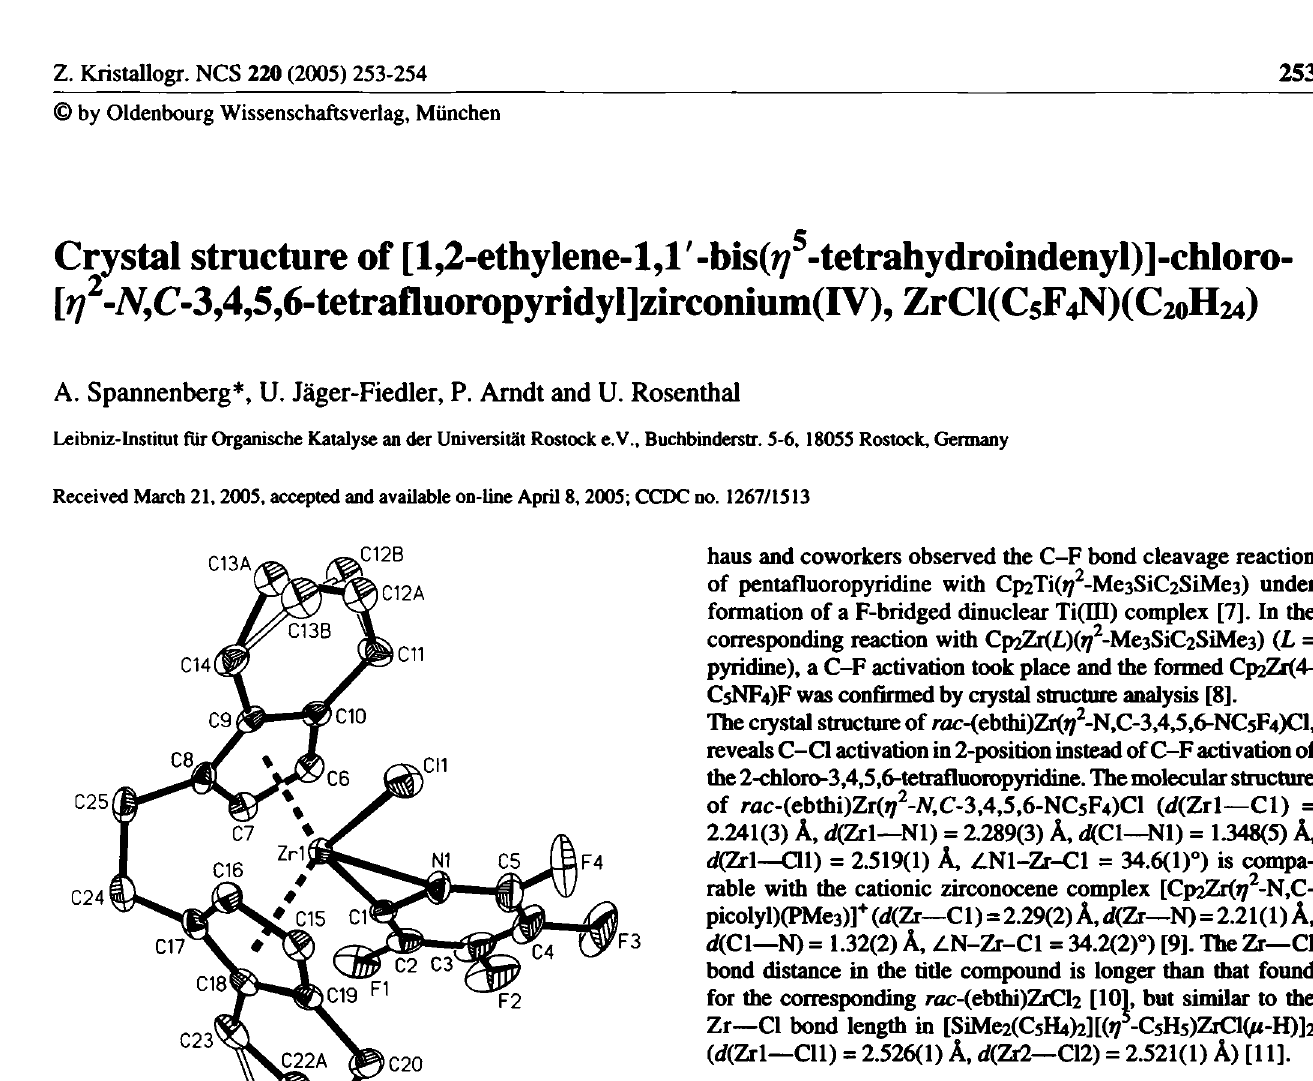
Table 1. Data collection and handling.